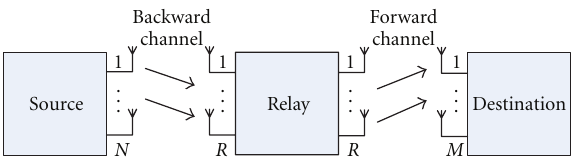
Figure 1: A MIMO relay